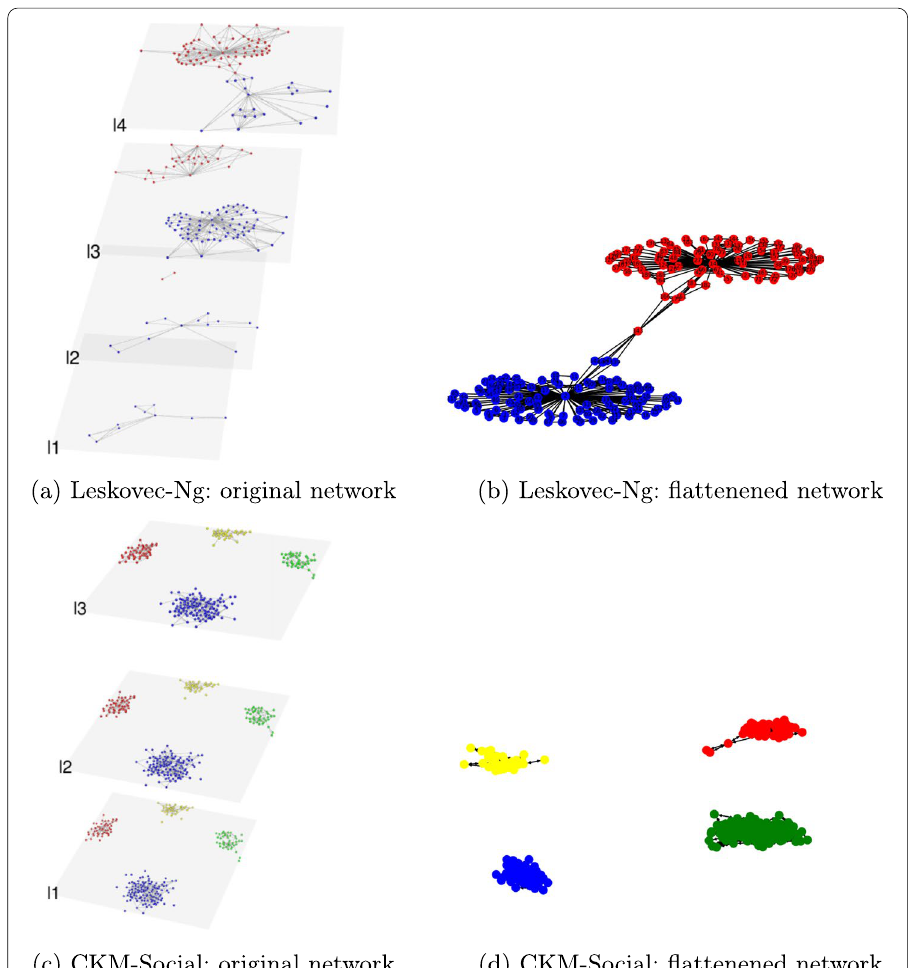
Fig. 6 Leskovec - Ng and CKM - Social networks before and after the flattening process. In Leskovec - Ng , blue nodes and red nodes correspond to Leskovec’s collaborators and to Ng’s collaborators, respectively. In CKM - Social , color codes correspond to different